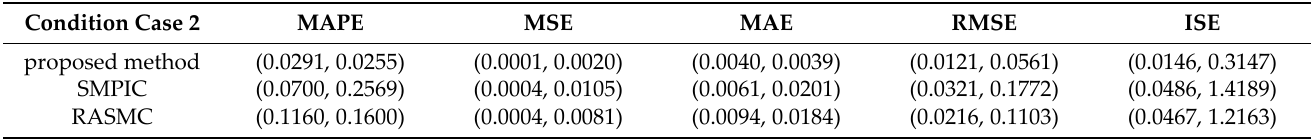
Table 5. The performance criteria indicators (hip, knee) under case 2 condition.